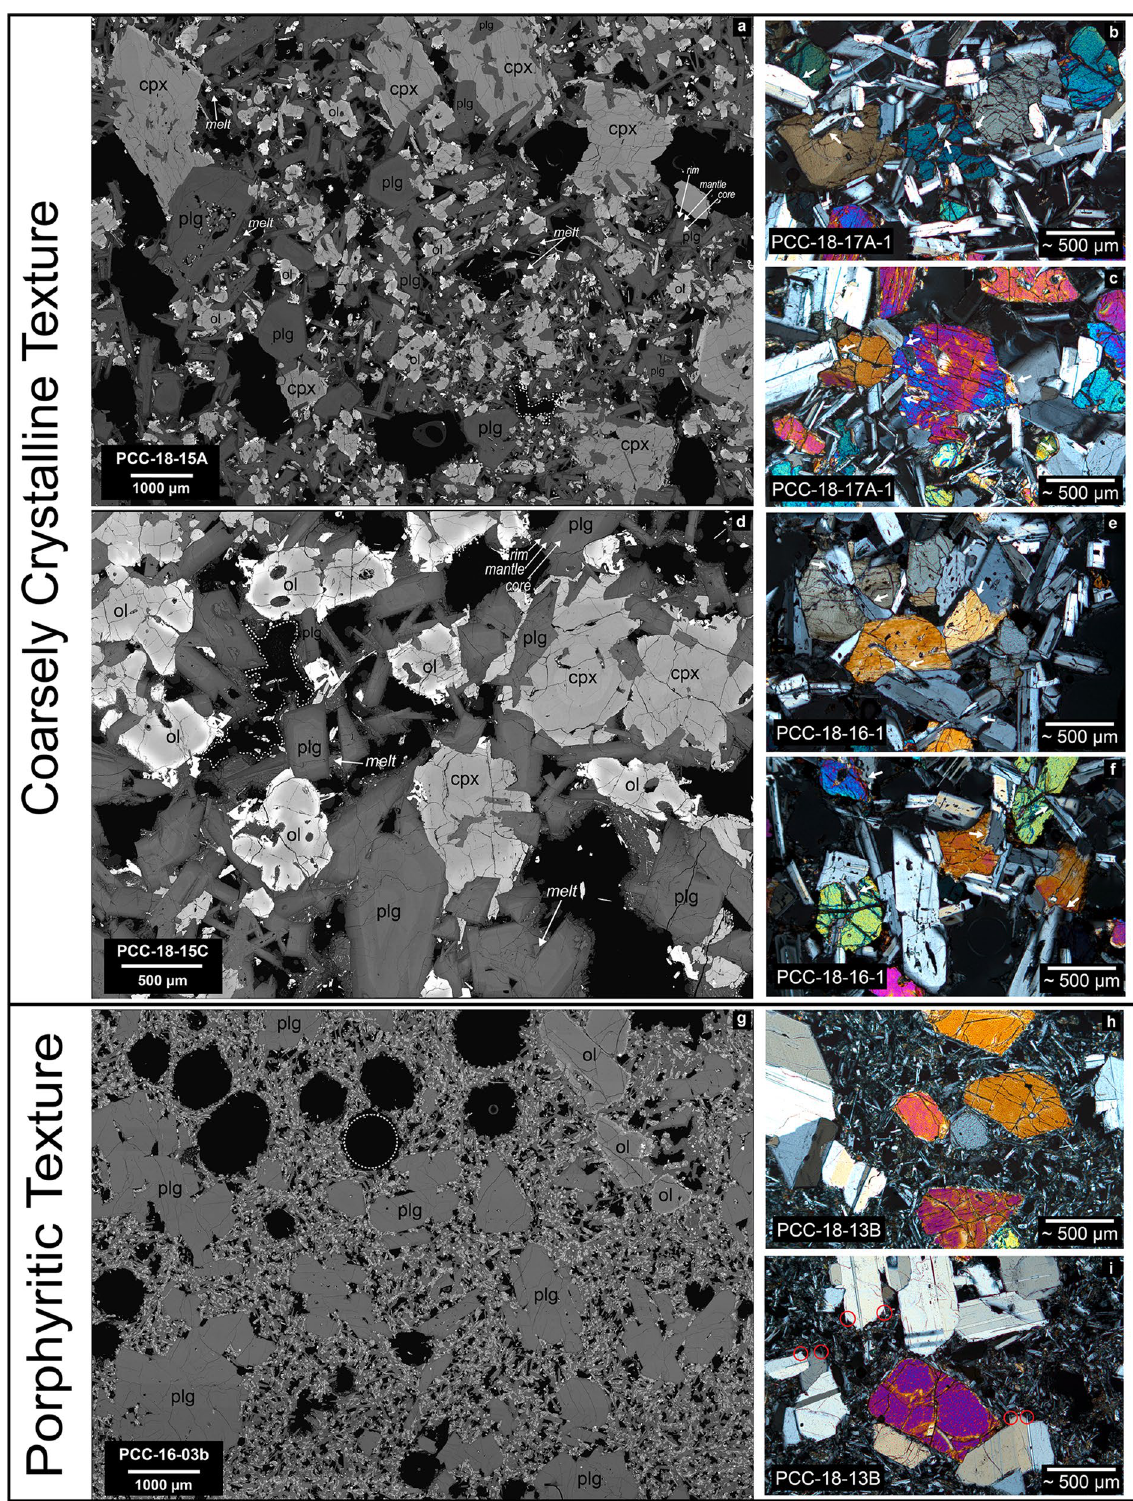
Figure 3. ( a – i ) Textural comparison of the coarsely-crystalline and porphyritic enclave populations using BSE maps and micrographs. Images highlight variations in crystallinity and vesicle shape differences with spherical vesicles in porphyritic enclaves and angular void-filling vesicles in the coarsely-crystalline population. Dotted white lines: highlight vesicle shapes in both enclave populations ( a , d , g ). ( b , c , e , f ) Micrographs display interlocking grain textures that are highlighted by white arrows. ( i ) Micrograph of porphyritic enclave with plagioclase clusters. Red circles highlight swallowtail disequilibrium textures of